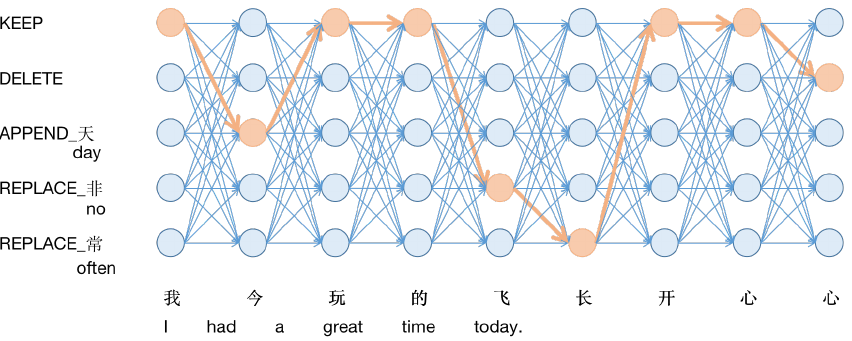
Figure 2. Each point represents a label possibility, the line between the points indicates the association between the labels and each of the labeled outcomes corresponds to a complete path on the